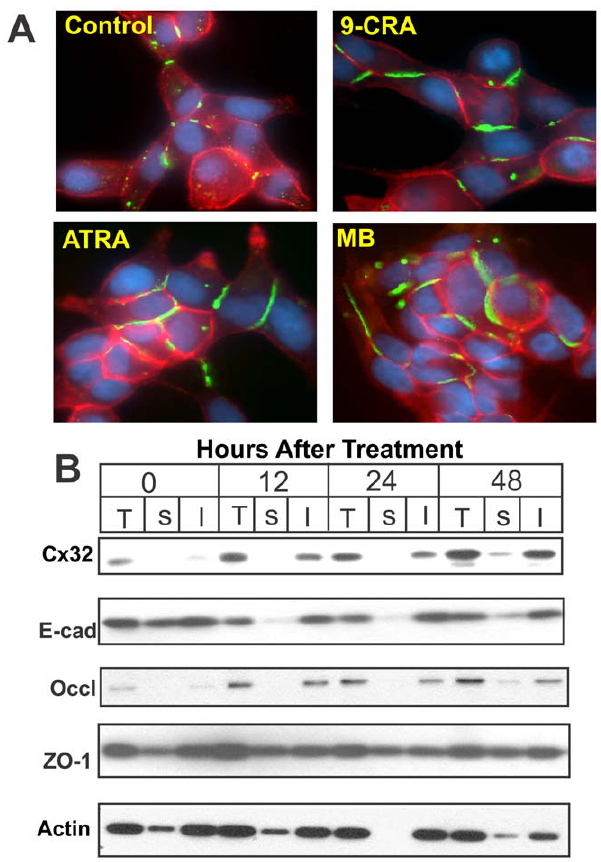
Figure 2. Retinoids enhance the assembly of Cx32 into gap junctions. A . LNCaP-32 cells, grown either in six well clusters or 10-cm dishes, were treated with 9-CRA and ATRA for various times. Assembly of Cx32 (green) into GJs was assessed immunocytochemically. E- cadherin is shown in red. Note that GJ formation was enhanced with 9- CRA and ATRA and MB treatment. B . Assembly of Cx32 into GJs, of tight junction associated protein, occludin and ZO-1, and adherens junction protein, E-cadherin, was assessed biochemically by TX100 insolubility assay as described in Materials and methods. Note also that both the total level and the detergent-insoluble fraction of Cx32 increased significantly. Note also that the detergent-solubility of adherens junction associated proteins, E-cadherin, is not significantly affected whereas that of tight junction associated protein, occludin, is marginally enhanced. In (A), the nuclei (blue) are stained with